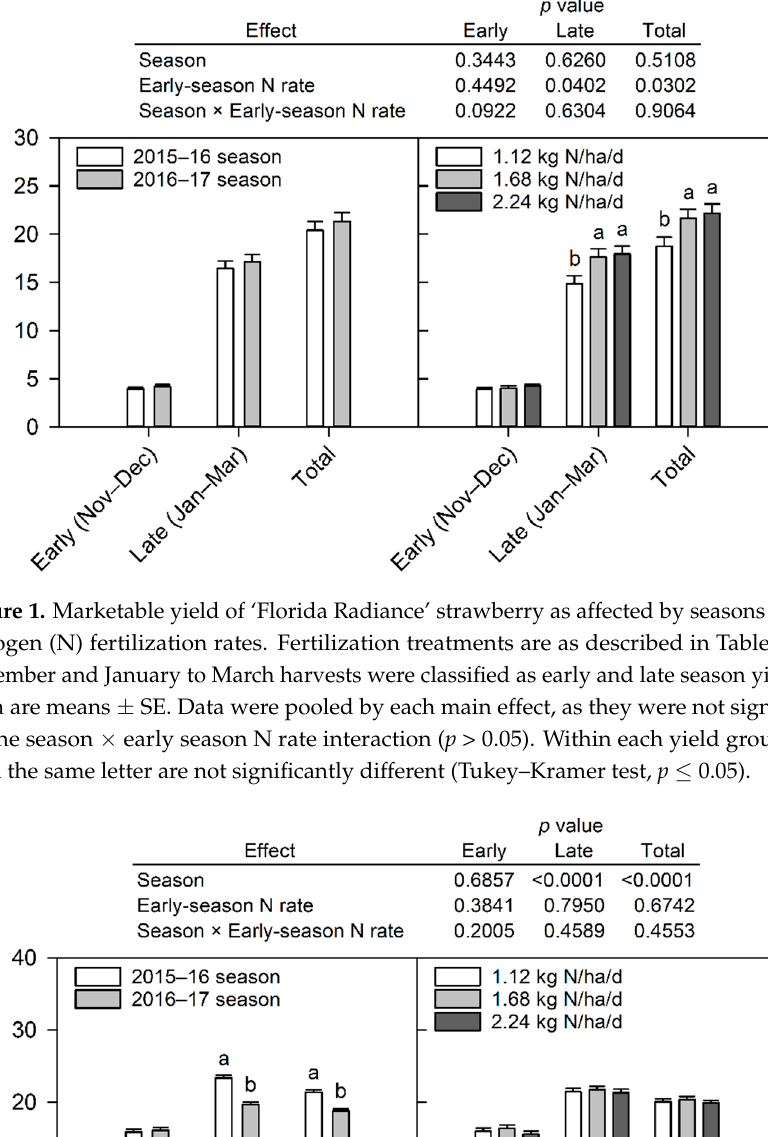
Figure 1. Marketable yield of ‘Florida Radiance’ strawberry as affected by seasons and early-season nitrogen (N) fertilization rates. Fertilization treatments are as described in Table 1. November to December and January to March harvests were classified as early and late season yields, respec- tively. Data are means ± SE. Data were pooled by each main effect, as they were not significantly affected by the season × early season N rate interaction ( p > 0.05). Within each yield group, bars followed with the same letter are not significantly different (Tukey–Kramer test, p ≤ 0.05).